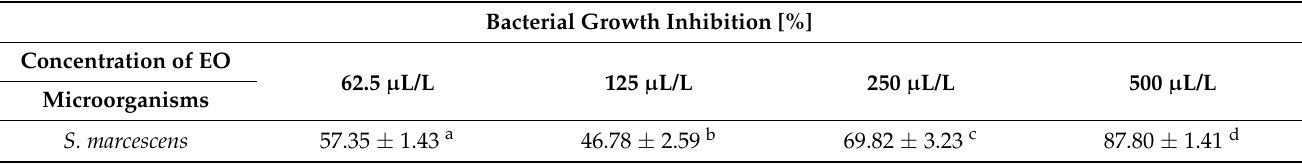
Table 4. Results of in situ analysis of antibacterial activity of the vapor phase of T. vulgaris essential oil on carrots. Bacterial Growth Inhibition [%] Concentration of EO 62.5 µ L/L 125 µ L/L 250 µ L/L 500 µ L/L Microorganisms S. marcescens 87.80 ± 1.41 d Means ± standard deviation. Values followed by different superscript within the same row are significantly different ( p < 0.05). The statistical differences ( p < 0.05) between individual EO concentrations were as follows: 62.5 µ L/L vs. 125 µ L/L, 250 µ L/L and 500 µ L/L; 125 µ L/L vs. 250 µ L/L and 500 µ L/L; 250 µ L/L vs. 500 µ